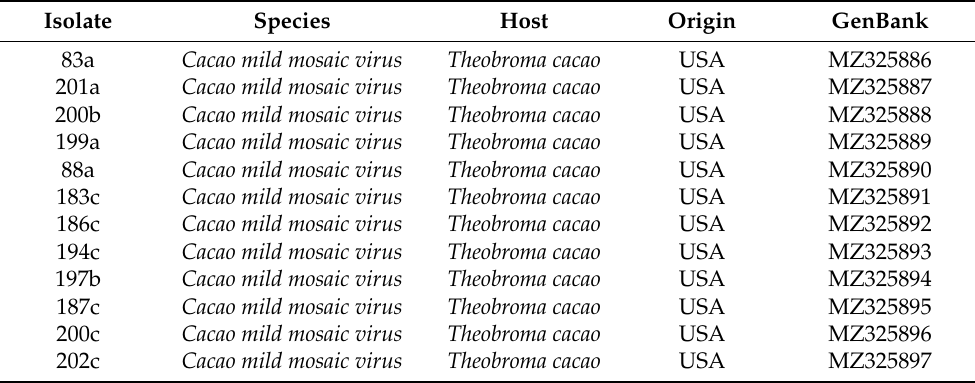
Table 2. A subset of the sequences of the coat protein–movement protein (CP-MP) region of Cacao mild mosaic virus generated in this study and deposited in Genbank. Sequences were amplified using a nested PCR (outer primers: Mia1145F/Mia1926R; inner primers: Mia1396F/Mia1876R) and sequenced with the internal primers. The letters designate from which leaf on the tree the sequence originated (a = leaf 1, b = leaf 2, c = leaf